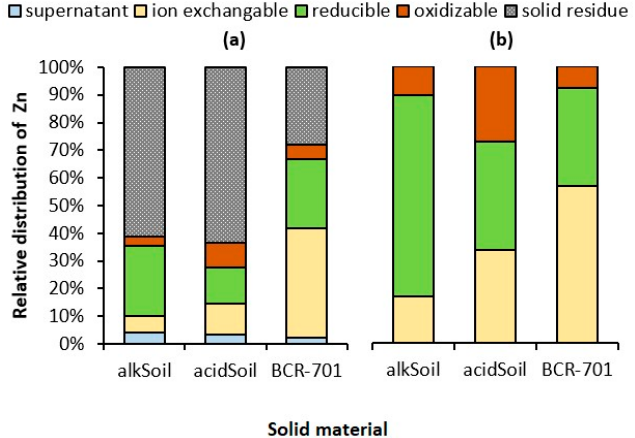
Figure 2. Zn distribution obtained for the uncontaminated solid materials alkSoil, acidSoil and BCR-701 using the modified BCR sequential extraction procedure. ( a ) presents the relative content of Zn contained in all fractions of the experiment and ( b ) only in the three fractions of modified BCR sequential extraction procedure: ion exchangeable, reducible and oxidizable fractions.